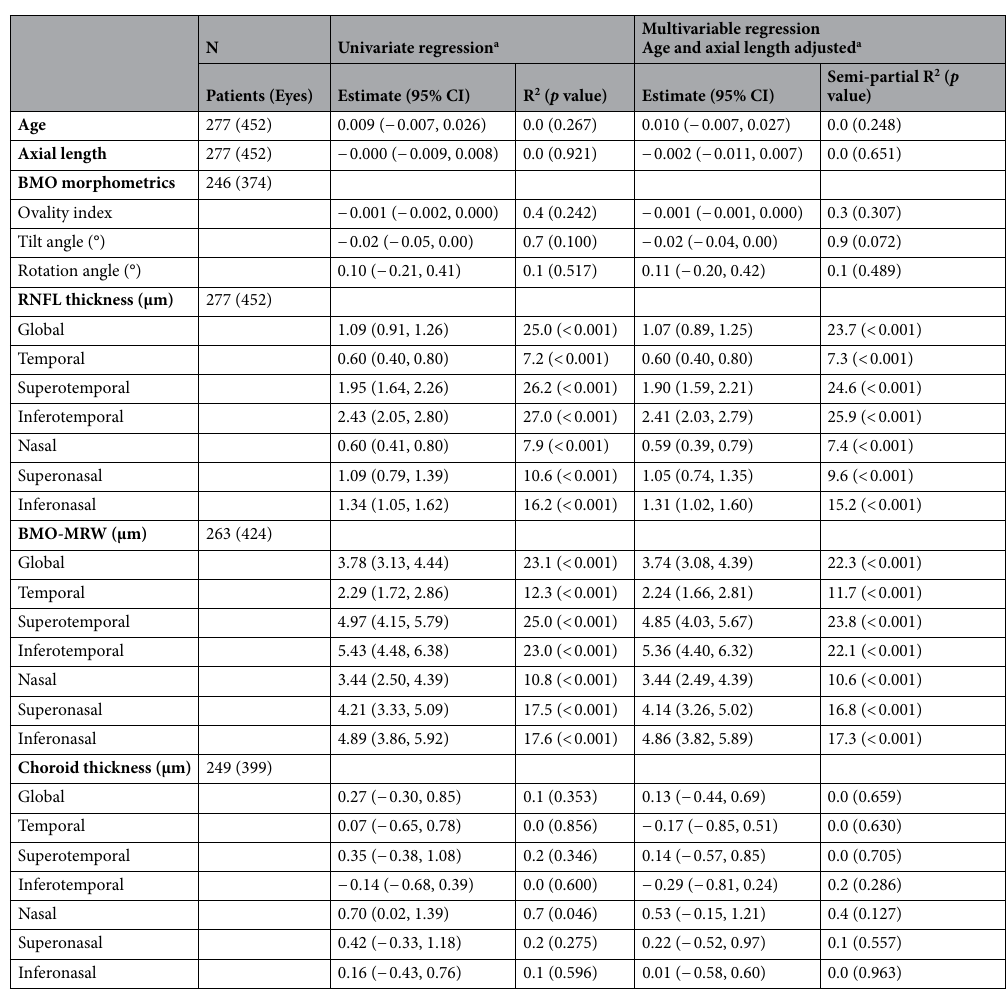
Table 4. The association of ocular characteristics with VF MD. BMO-MRW, Bruch’s membrane opening minimum rim width; CI, confidence interval; ONH, optic nerve head; RNFL, retinal nerve fiber layer; VF MD, visual field mean deviation. a Linear mixed models slope estimates (with 95% confidence intervals) from univariate and multivariable models adjusted for age and axial